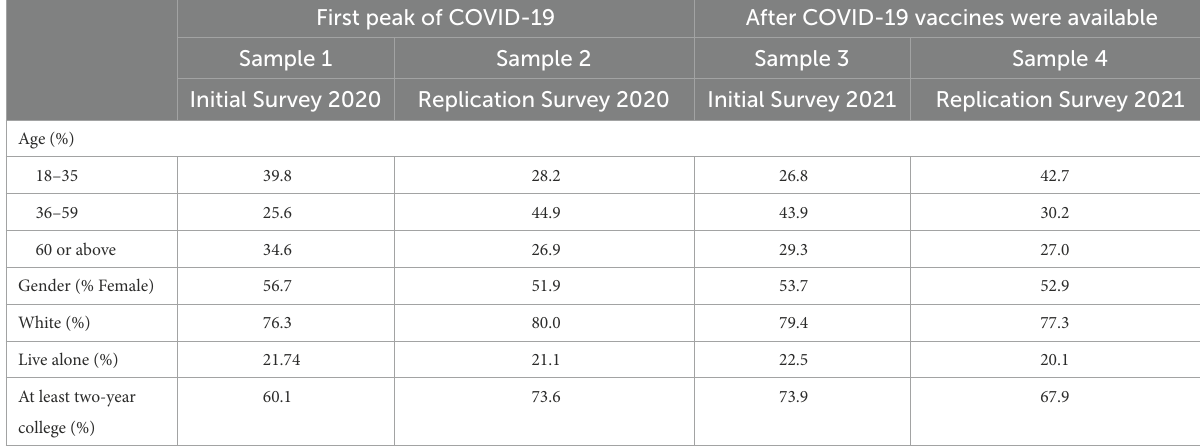
TABLE 1 Age, gender, ethnicity, household structure, and education by